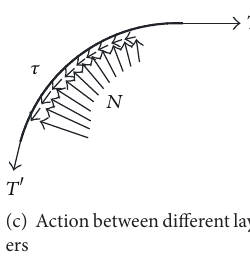
Figure 1: Diagram of the principle of the anchor